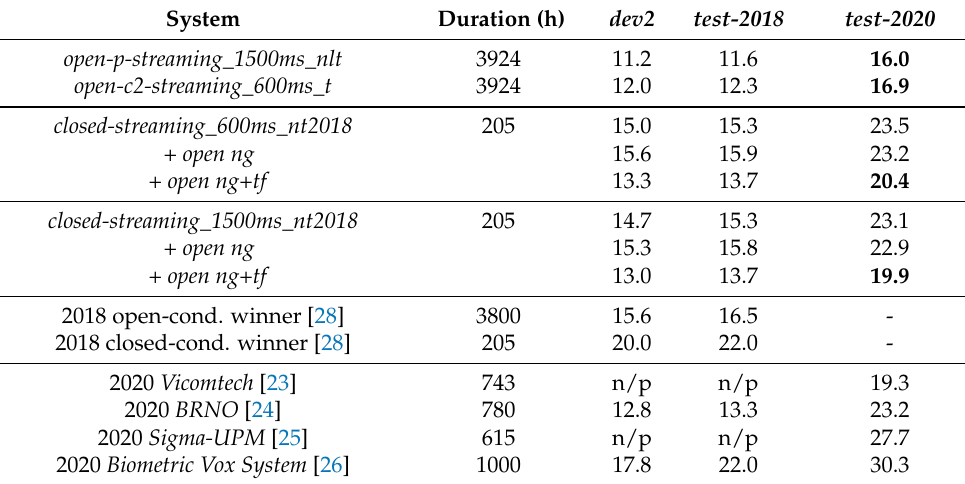
Table 7. WER of our main (open) submissions and our closed-condition systems described in this section, including for comparison the winning open- and closed-condition systems of the 2018 challenge, computed over the dev2 , test-2018 and test-2020 sets. Highlited in bold, the most relevant results to compare open and closed conditions in the main test set test-2020